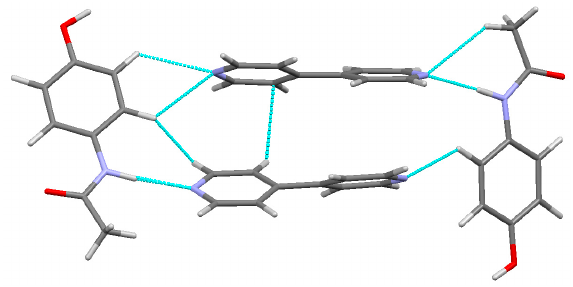
Figure 9 . Packing diagram of the bonding motif found in ( 3 ) [28]. Figure 9. Packing diagram of the bonding motif found in ( 3 )